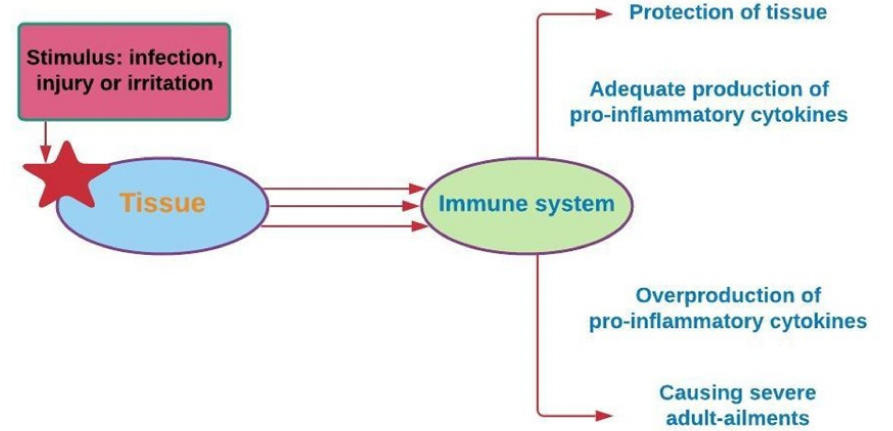
Figure 6. The occurrence of chronic diseases is associated with the overproduction of pro-inflammatory cytokines